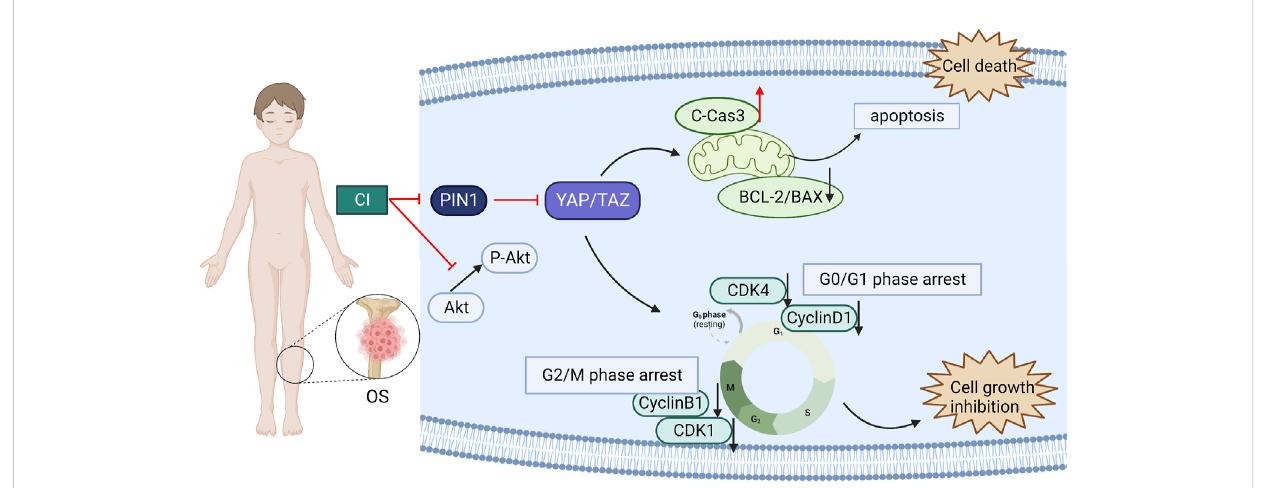
A schematic diagram of the effect of CI on human OS cells. CI induced G2/M or G0/G1 cell cycle arrest and apoptosis in human OS cells through inhibition the PIN1-YAP/TAZ signaling